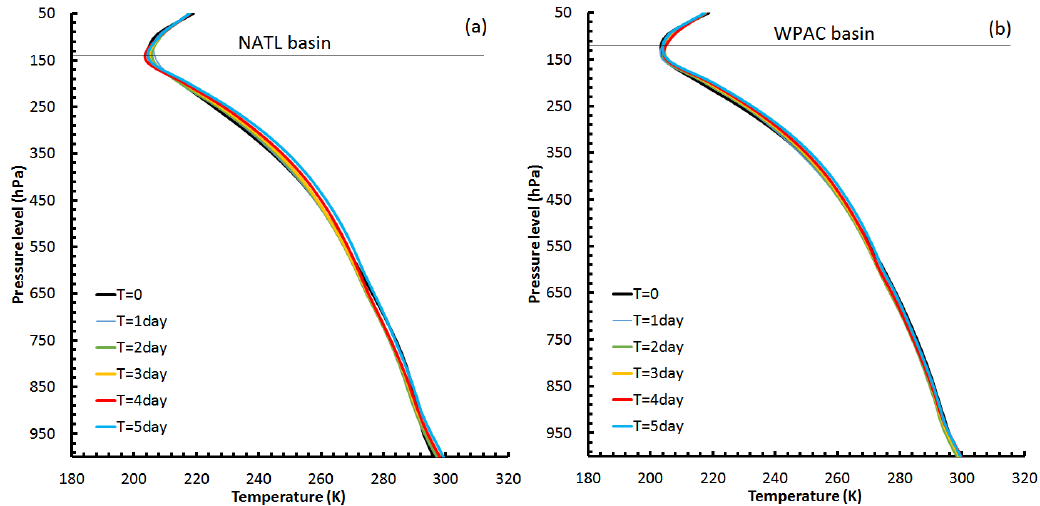
Figure 2. The evolution of the area-averaged temperature profiles (solid lines) within a radius of 500 km from the model storm center that are obtained from the Hurricane Weather Research and Forecasting (HWRF) model with the August mean sounding in ( a ) the NATL basin, and ( b ) WPAC basin valid at T = 0 (black), T = 1 day (blue), T = 2 days (green), T = 3 days (orange), T = 4 days (red), and T = 5 days (cyan). Thin lines denote the corresponding tropopause level in each